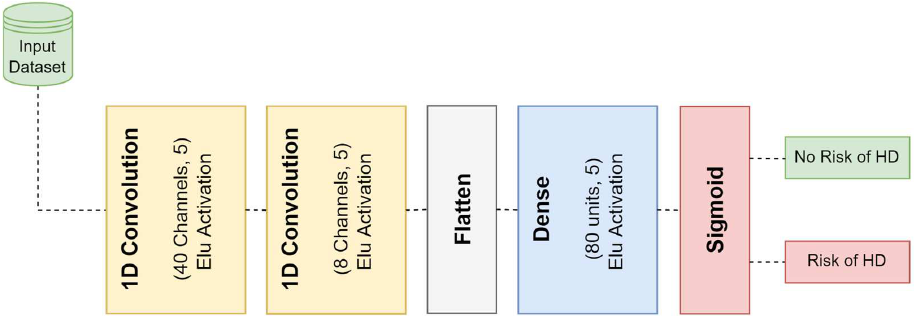
Figure 4. Block diagram of the proposed 1D-CNN architecture. Table 2. A summary table of the proposed 1D-CNN model.